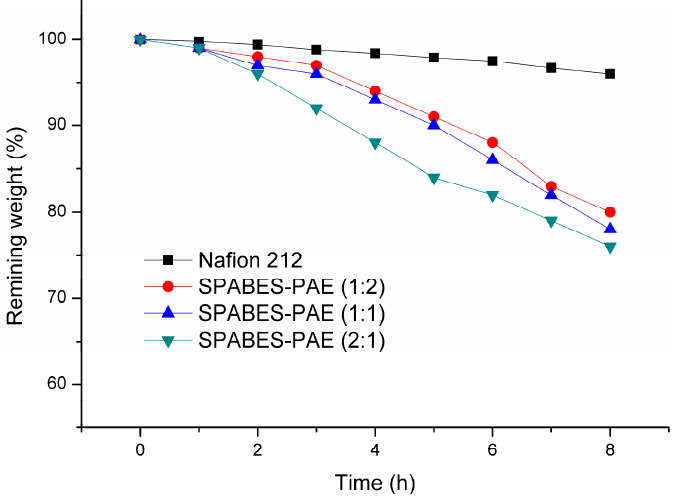
Figure 6. Accelerated oxidative stability test in 4 ppm Fe 2+ Fenton’s reagent at 60 °C.